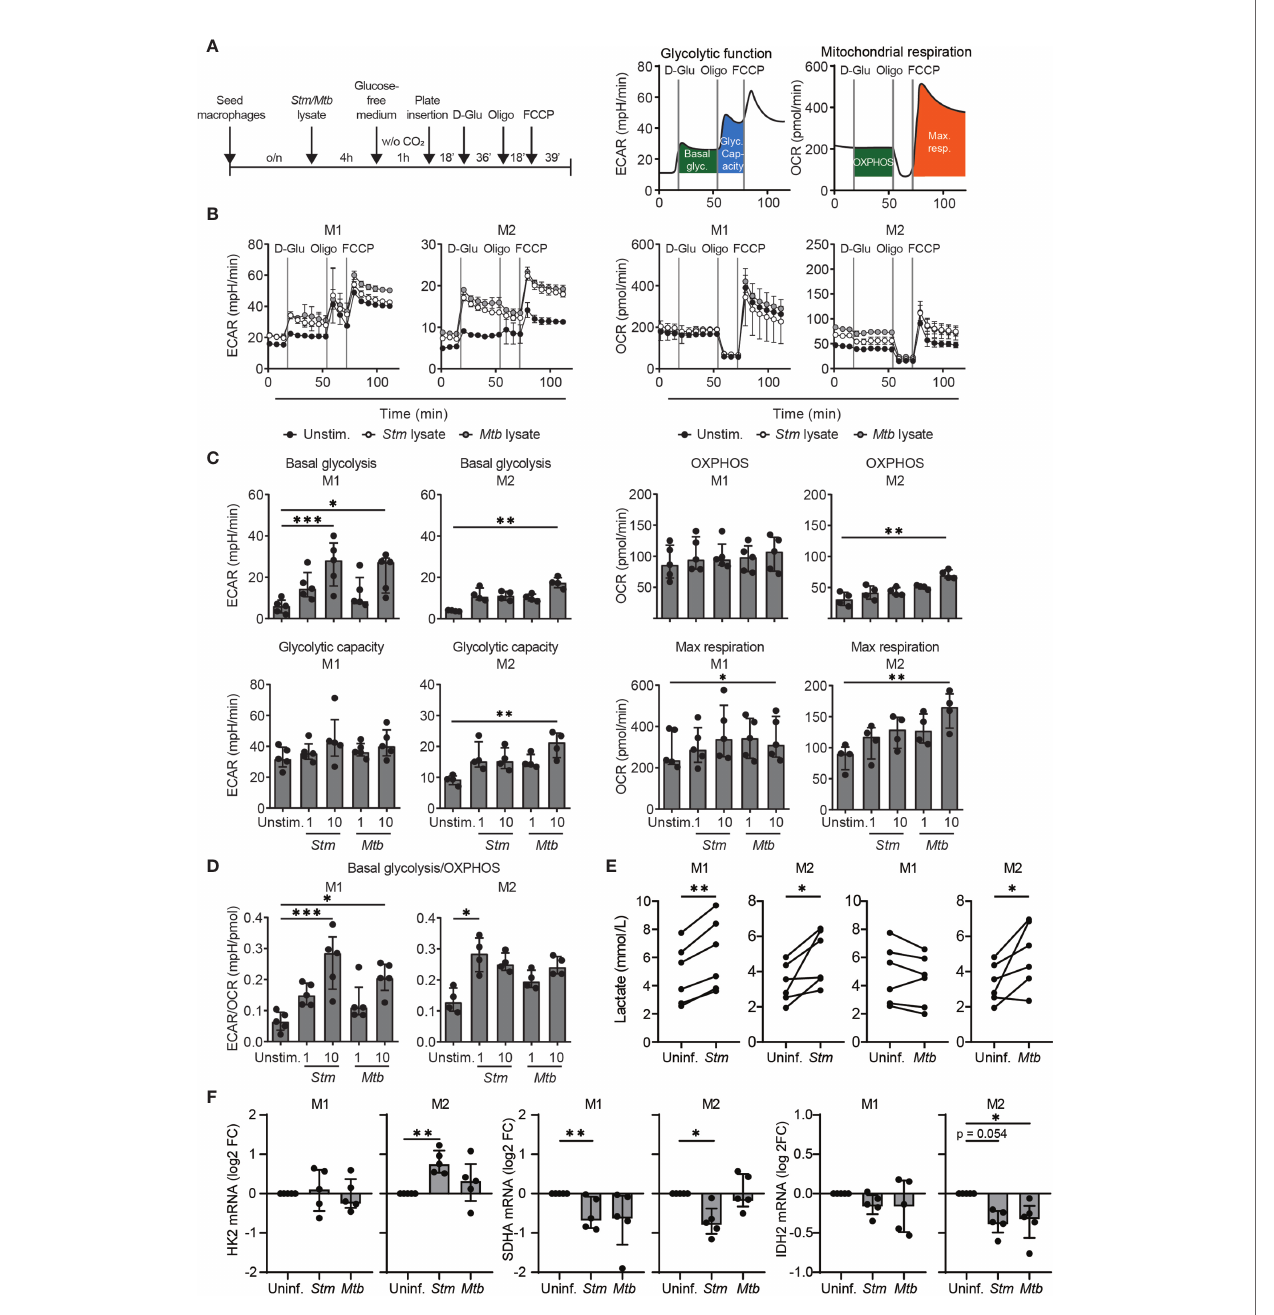
FIGURE 1 | Stm and Mtb induced a more glycolytic phenotype in human macrophages. (A) Schematic representation of the experimental setup used in (B – D) (left panel) and a representative ECAR and OCR pro fi le indicating basal glycolysis (basal glyc.), glycolytic capacity (glyc. capacity), OXPHOS and maximal respiration (max. resp.) (right panel). M1 and M2 were unstimulated (unstim.) or stimulated with 1 µg/ml Stm or Mtb lysate for 4 hours and inserted in the Seahorse analyzer. D-glucose (10 mM), oligomycin (oligo, 1 µM) and carbonyl cyanide 4-(tri fl uoromethoxy)phenylhydrazone (FCCP, 2 µM) were sequentially injected after 18, 54 and 72 minutes, respectively. (B) ECAR (mpH/min, left panel) and OCR (pmol/min, right panel) pro fi les of one representative donor out of fi ve (M1) or four (M2) donors analyzed. Data represent the mean ± S.D. of triplicates. (C, D) Basal glycolysis, OXPHOS, glycolytic capacity, maximum respiration and the ratio between basal glycolysis and OXPHOS (ECAR/OCR) in M1 (left panels) and M2 (right panels). Data represent the median ± interquartile range of minimally four donors. Differences were signi fi cant by RM one-way ANOVA with Dunnett ’ s multiple test correction against the unstimulated control. (E) Lactate production was measured in the supernatant of M1 and M2 that were infected with Stm or Mtb overnight. Lines connect data points from the same donor, with a total of six donors tested. Signi fi cant differences were tested using a paired t-test. (F) HK2, SDHA and IDH2 mRNA expression levels were quanti fi ed in Stm - or Mtb -infected M1 and M2 at 4 hours post infection using GAPDH as the housekeeping control gene. Data represent the median ± interquartile range of fi ve donors. Differences were signi fi cant by RM one-way ANOVA with Dunnett ’ s multiple test correction against the uninfected control. *p < 0.05, **p < 0.01, ***p <